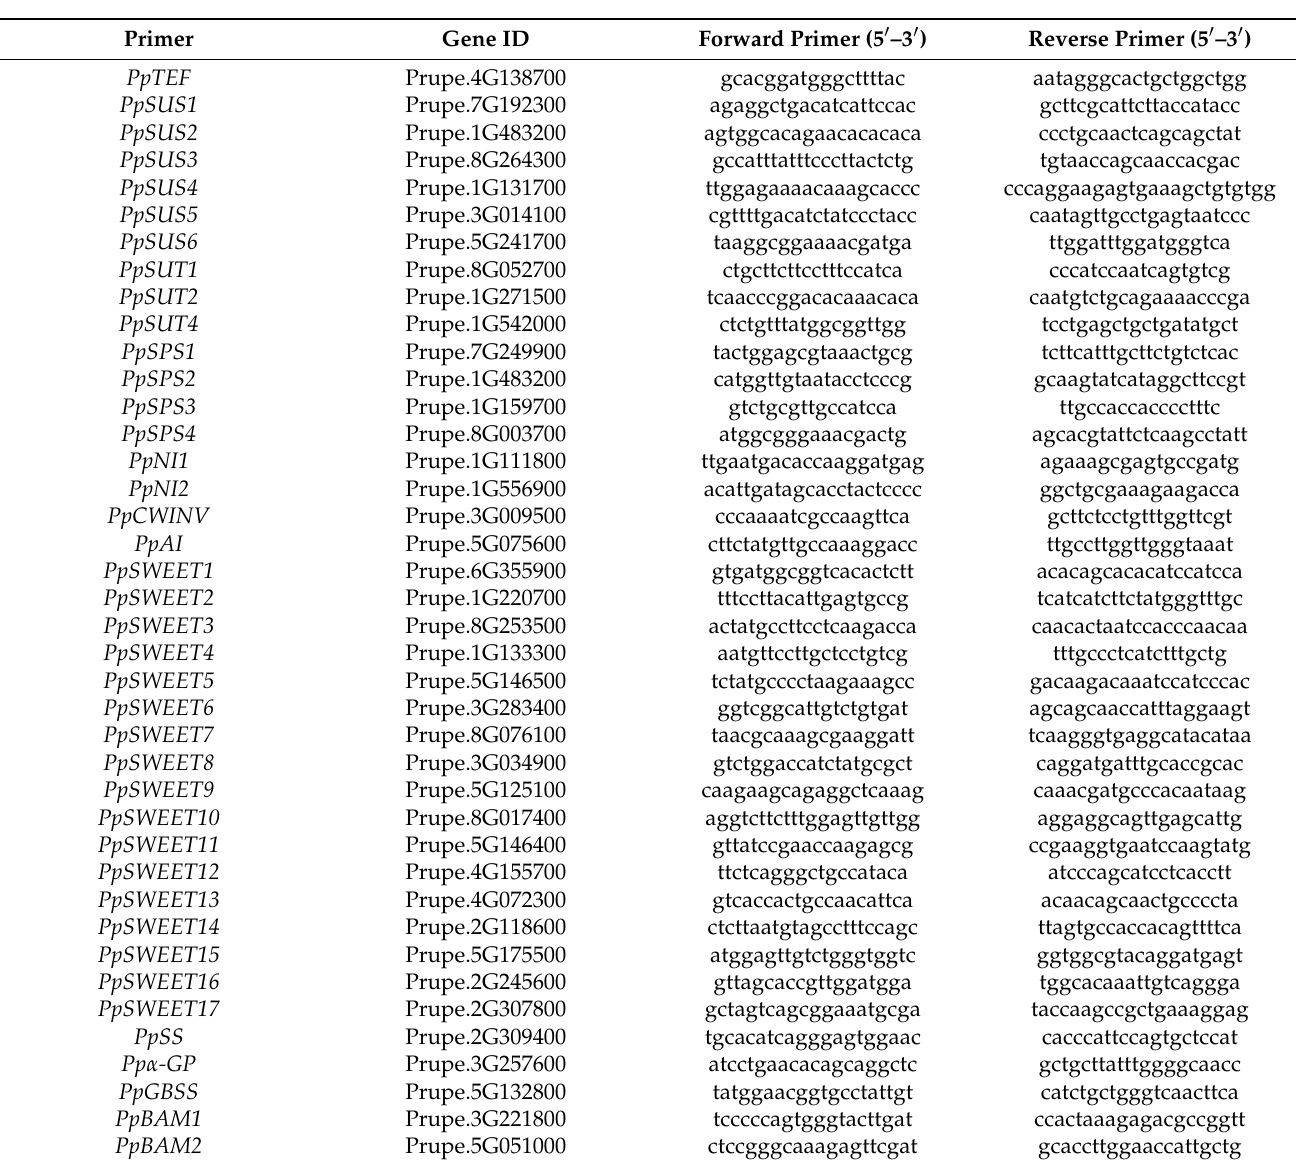
Table A1. Primer sequences designed for RT-qPCR of